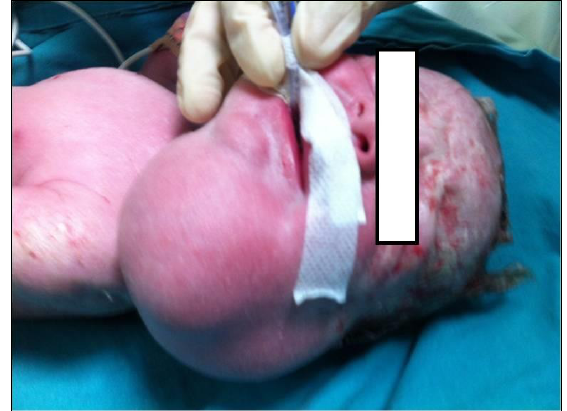
Figure 2: Airway secured during EXIT.